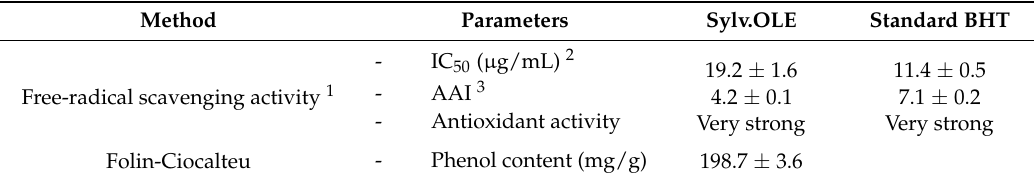
Table 1. Total phenol content and free-radical scavenging activity of leaves extract from Algerian oleaster ( O. europaea var. sylvestris